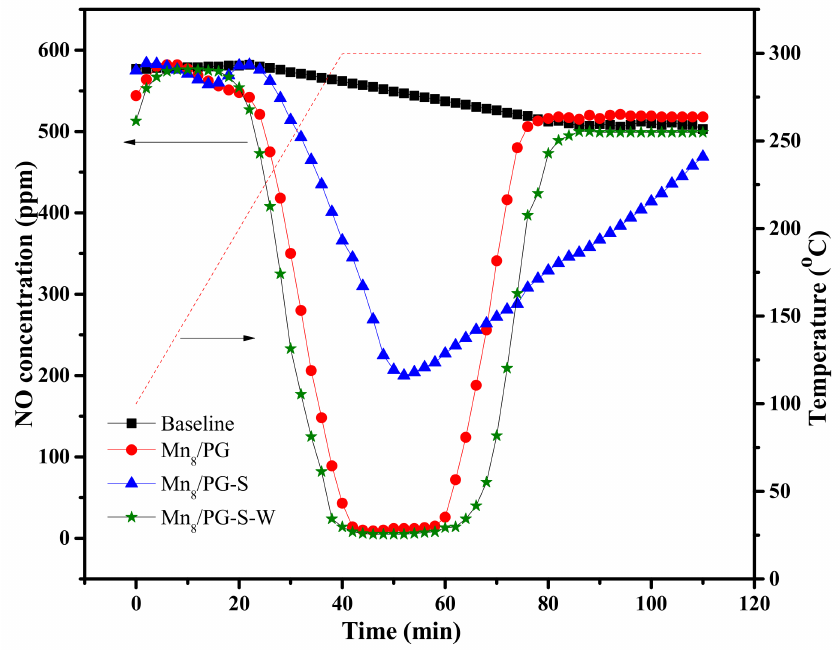
Figure 12. NH 3 adsorption and desorption curve for different MnO 8 /PG catalysts. Reaction con- ditions: 600 ppm of NO, 3% O 2 , Ar as a balance, total flue rate: 350 mL · min − 1 , GHSV: 7000 h − 1 , heating rate (5 ◦ C · min − 1